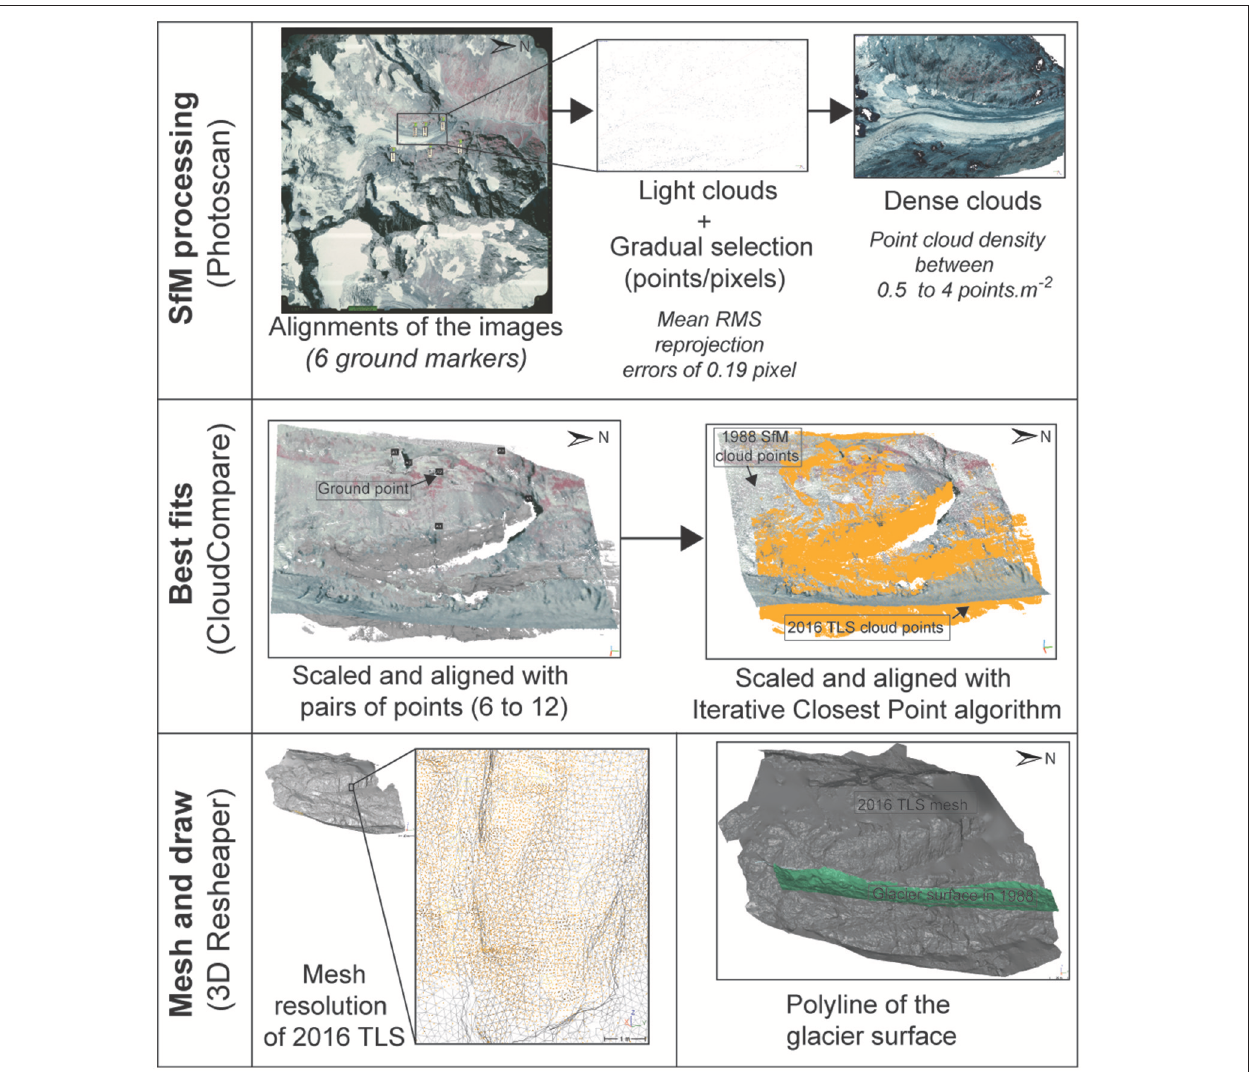
FIGURE 4 | Work flow of the SfM and TLS processing procedures, from the creation of point clouds to the drawing of polylines on the glacier surface (example with 1988 image).